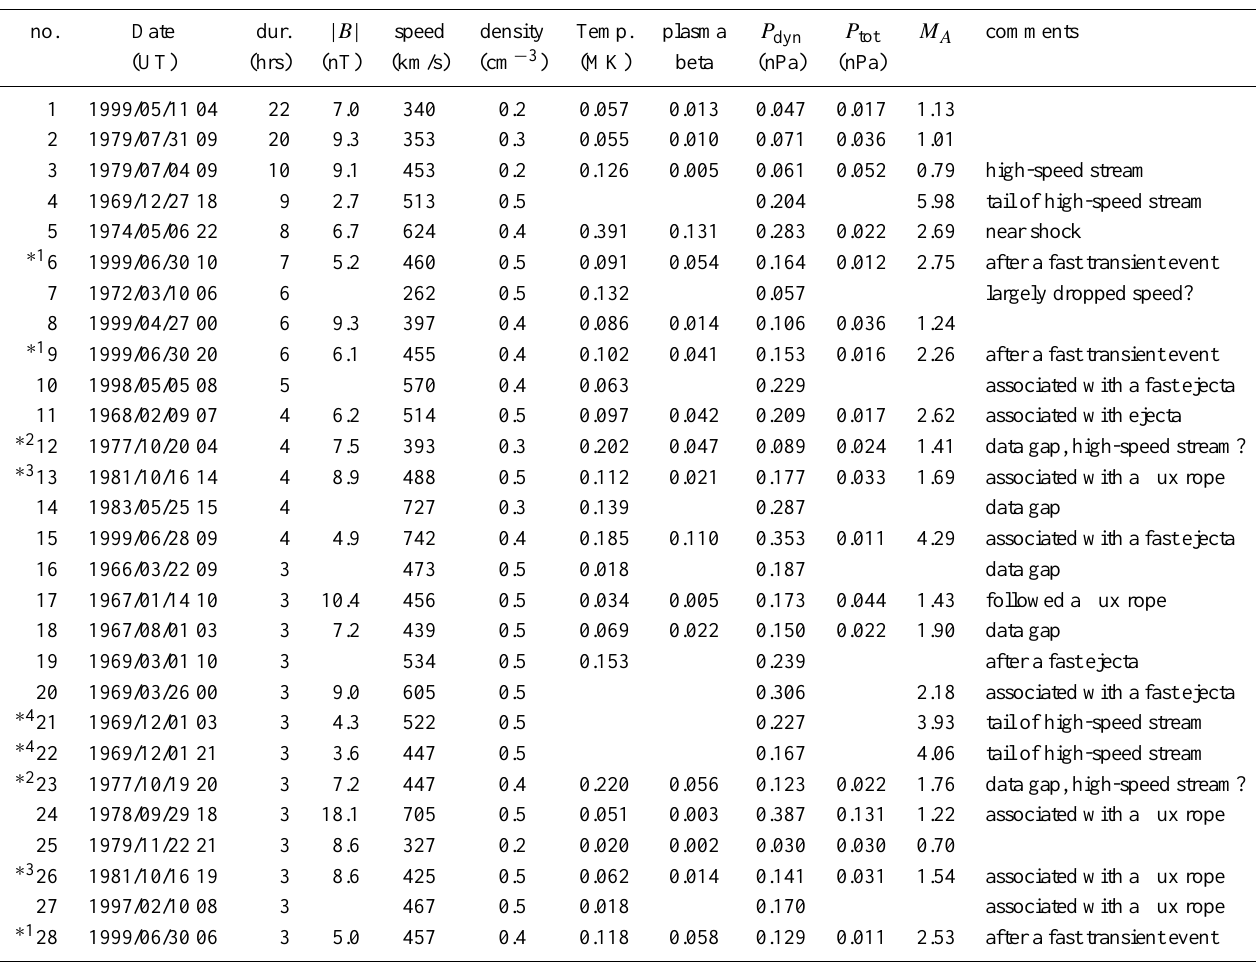
Table 1. Averaged values of solar wind parameters in the long-duration low-density solar winds